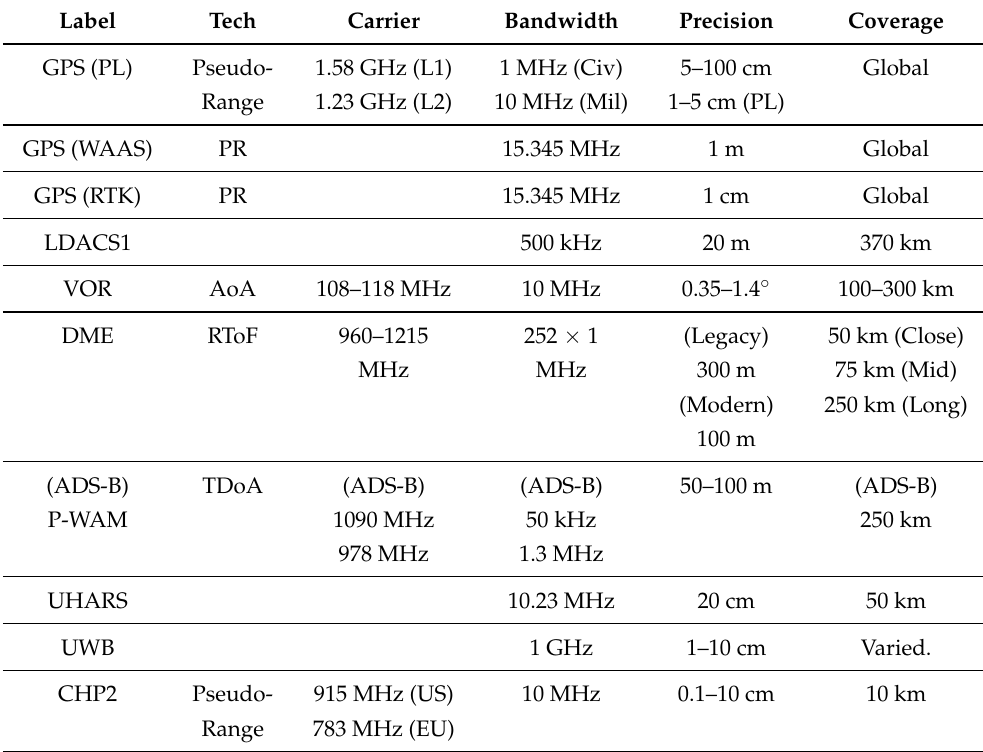
Table 1. Performance Comparison of CHP2, PNT, and APNT Technologies [10,26–41].